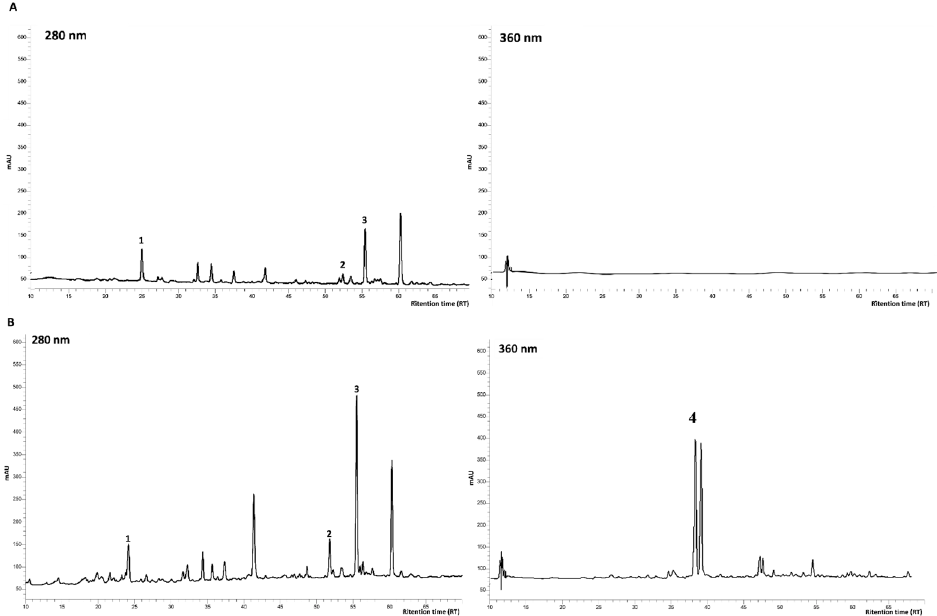
Figure 3. Example chromatograms of polyphenols fraction. ( A ): Sample 1b (SPE Soxhlet oil), polyphenolic profile at 280 and 360 nm; ( B ): Sample 2b (SPE CO 2 oil) polyphenolic profile at 280 and 360 nm. Identified peaks: 1. Coumaric acid; 2. Carvacrol; 3. Thymol; 4. Quercetin-3-D-galactoside. Table 1. HPLC-DAD quantitative analysis of the SPE Soxhlet oil, 1b , and scCO 2 oil, 2b . Results are expressed in µ g/g of crude